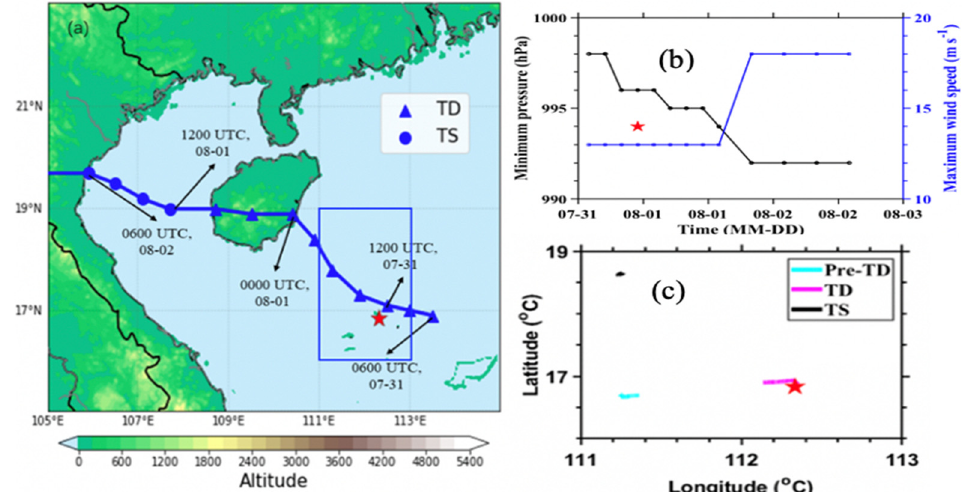
Figure 2. The track of Typhoon Sinlaku (2020) passing through the South China Sea, which moved from southeast to northwest; the solid blue triangle represents the location of a tropical depression (TD) and the solid circles represent the locations of tropical storms (TS). The red pentagram in the left panel represents Xisha station (112.33°E, 16.83°N). Also shown are ( b ) the minimal central pressure and maximum wind speed and ( c ) the spatial extent (blue rectangle in panel a ) of the trajectory of the drifting balloon and the dropsondes that correspond to the three different stages of Typhoon Sinlaku (2020) for the study period: pre-TD stage in cyan solid line, TD stage in magenta solid line, and TS stage in black solid line. The red pentagram in the right panel represents the time when the typhoon passes over Xishan station. Note that the time is in UTC.